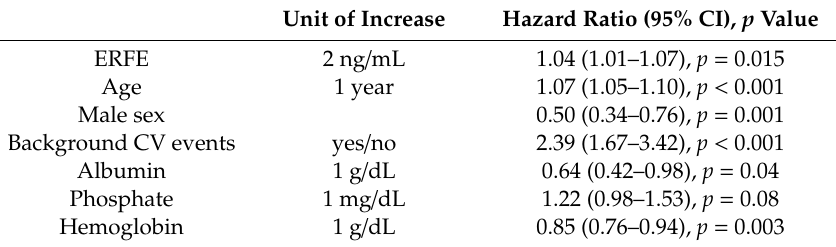
Table 3. Adjusted association between serum ERFE and mortality and non-fatal CV events in the CKD